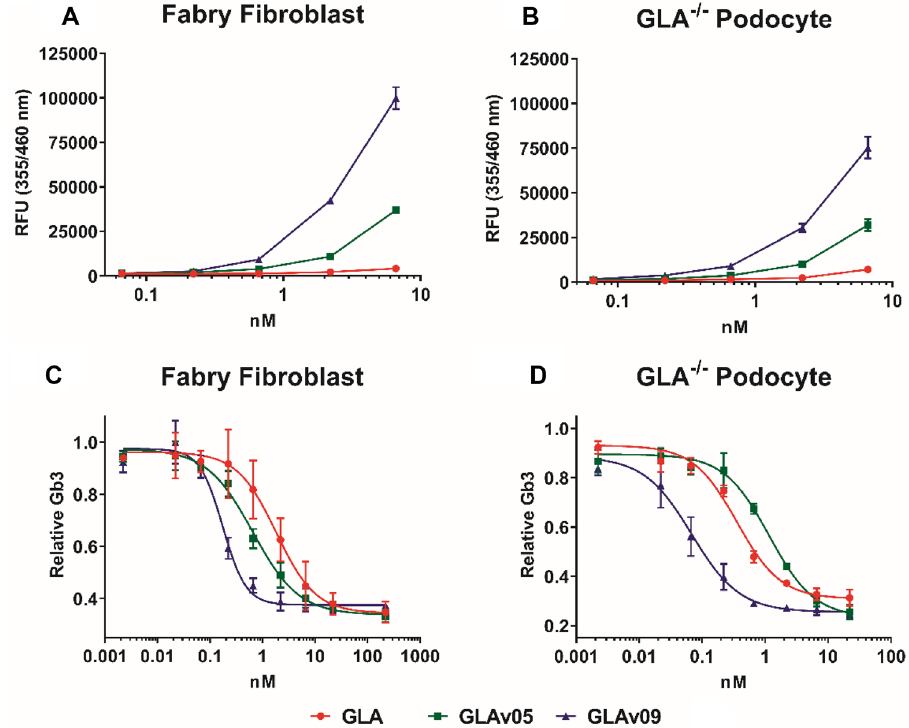
Figure 3. GLA activity and Gb3 degradation in cells following treatment with GLA variants. Cells were treated with GLA (red circles), GLAv05 (green squares), or GLAv09 (blue triangles), incubated for 7 days, then lysed for analysis. 4-MU-Gal hydrolysis activity of lysates ( A , B ) and LC-MS quantitation of Gb3 substrate ( C , D ) is shown for Fabry patient fibroblasts ( A , C ) and GLA −/− podocytes ( B , D